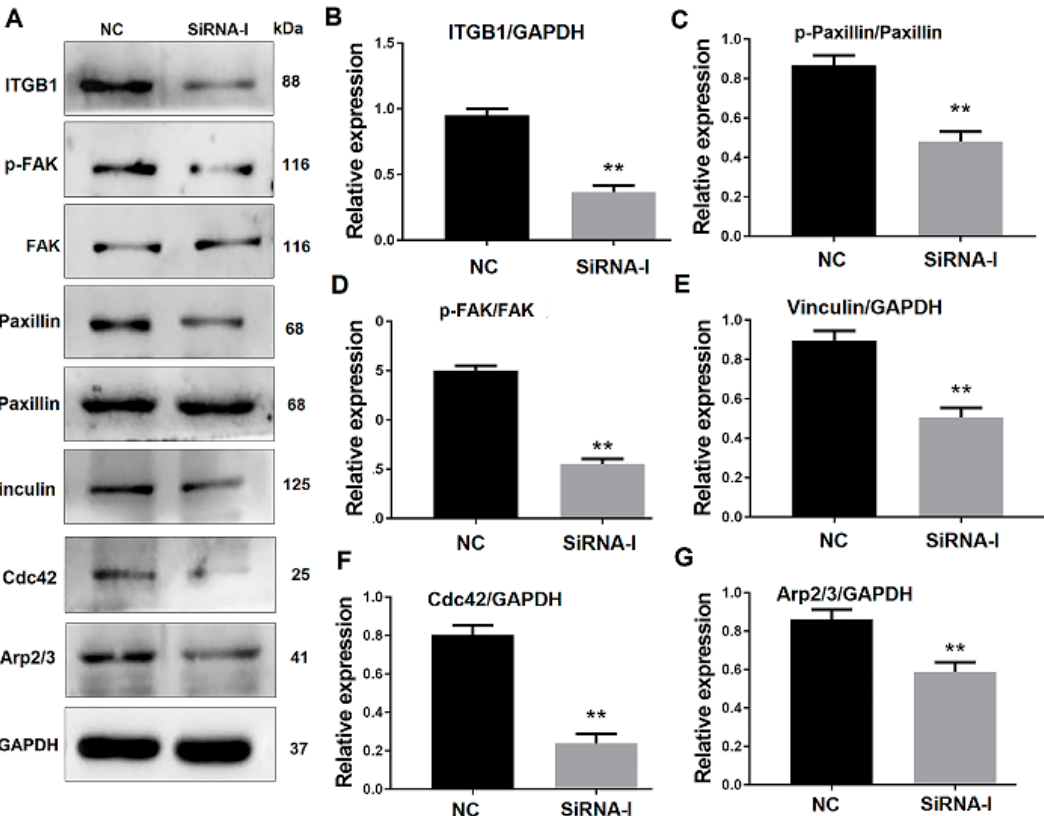
Figure 3. ITGB1 inhibition affects downstream gene expression. ( A ) Western blotting images of proteins related to the ITGB1-mediated signaling pathway at 48 h after ITGB1 inhibition. ( B-G ) Quantification of the ITGB1, p-FAK, p-paxillin, vinculin, Cdc42, and Arp2/3 Western blotting results presented in A. ** p < 0.01.